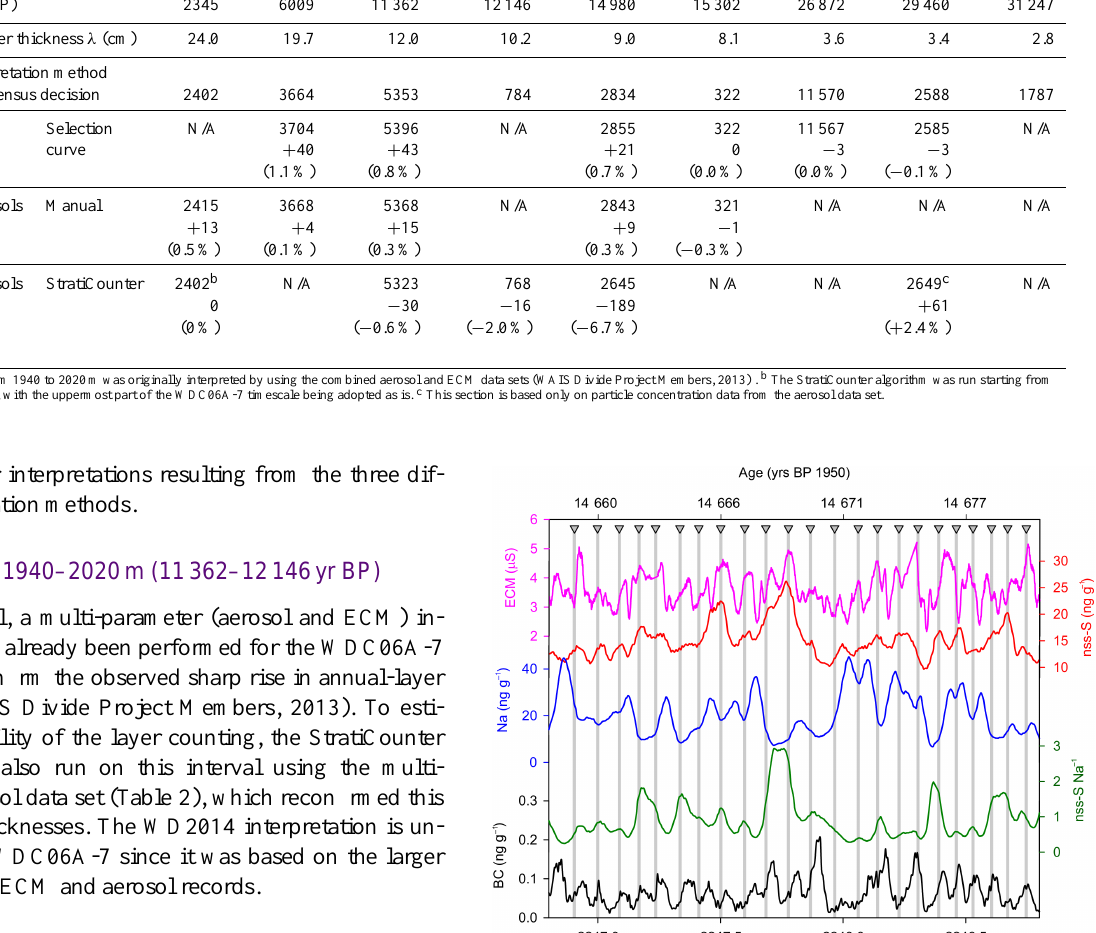
Table 2. Constructing the WD2014 ice core chronology: annual-layer interpretation results using various data and interpretation techniques. N/A ice core section was not annually dated with the respective dating method or data. Depth interval (m)